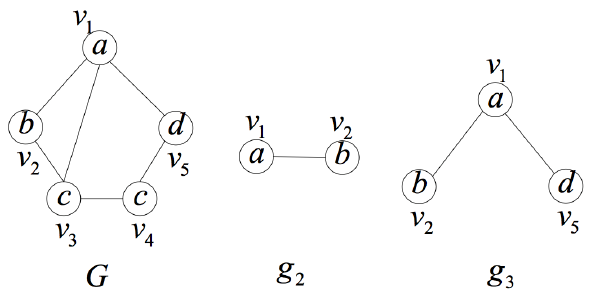
Figure 4. An example to show the importance of searching induced subgraphs in ascending order of the number of